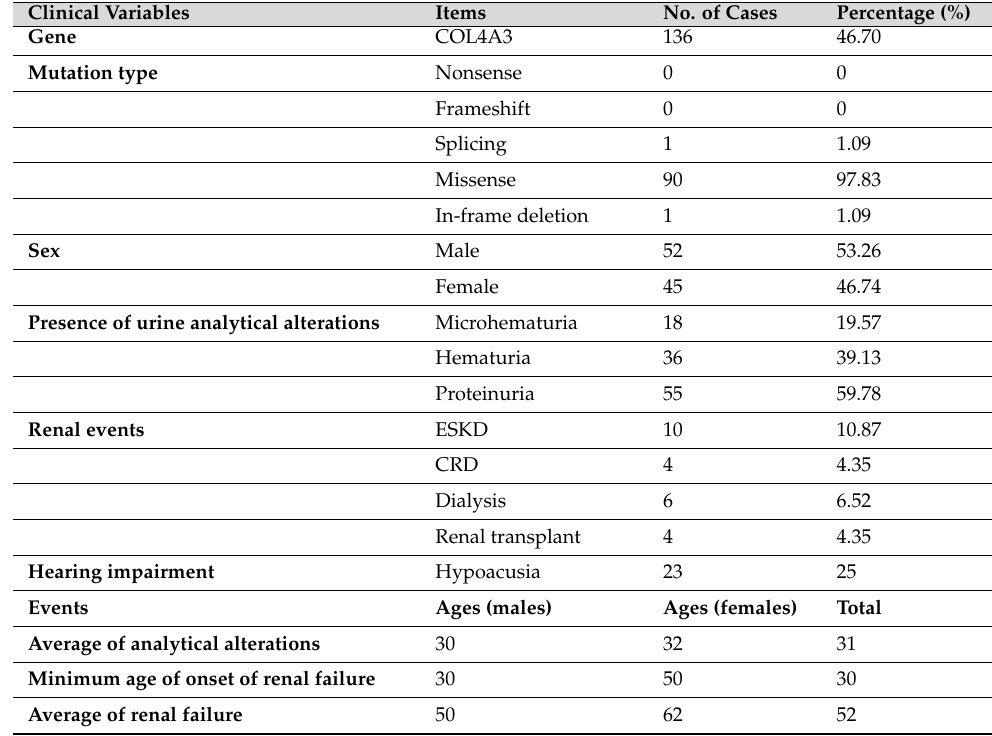
Table 1. A summary of the clinical data on patients with heterozygous deleterious mutations in COL4A3